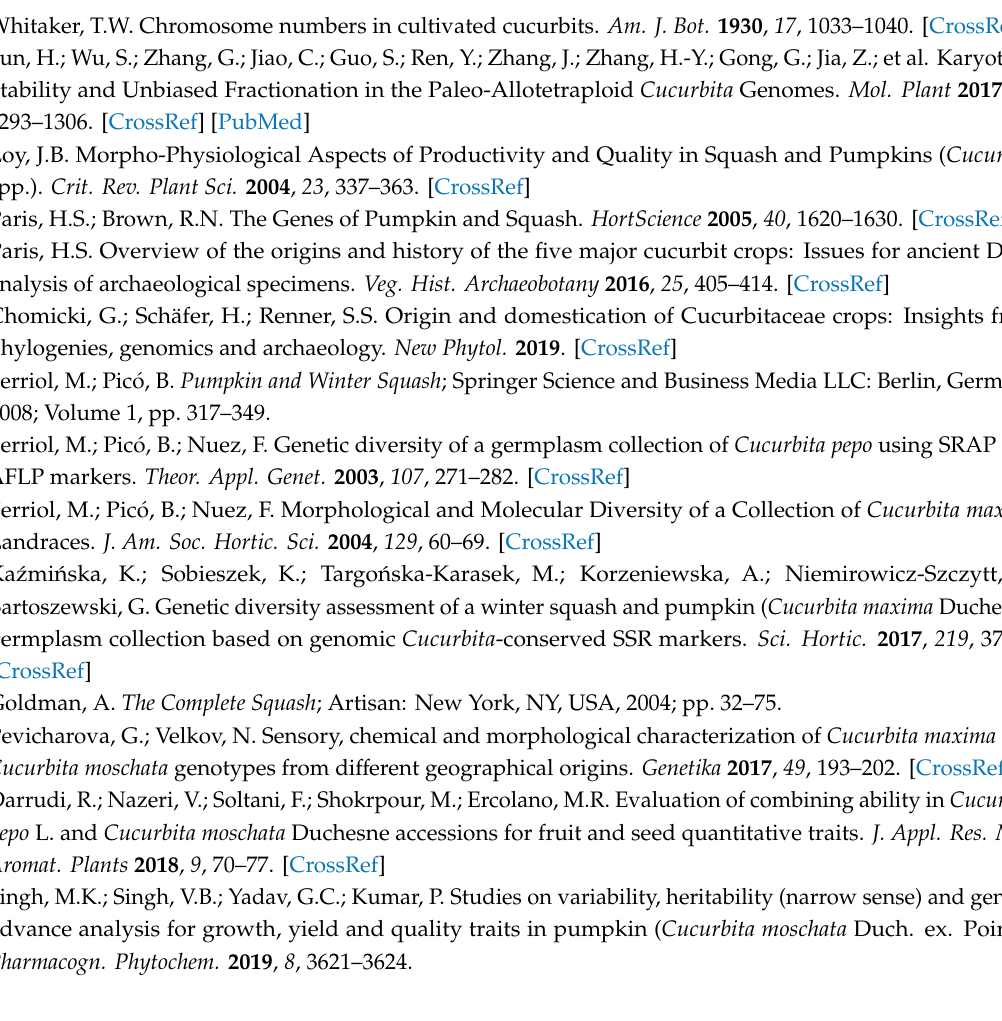
Table S3: Genetic map of C. maxima developed by Ka´zmi´nska et al. (2018) with fruit-associated QTLs positions (n.d.—not determined, marker not found in the genome). Table S4: Genomic regions corresponding to QTLs intervals (QTLs intervals identified in two